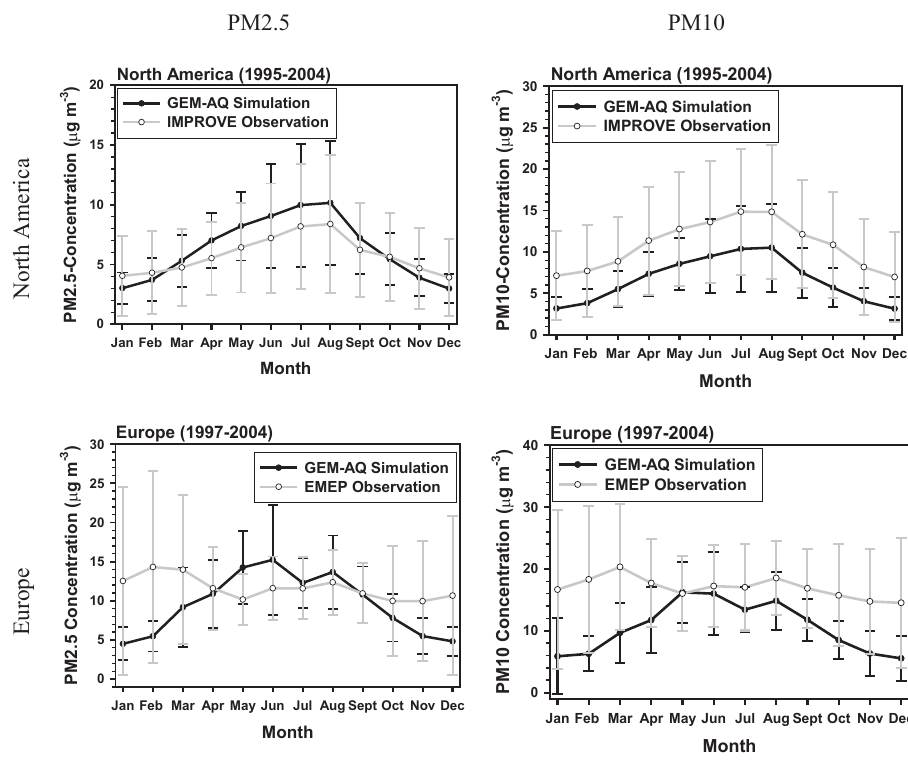
Fig. 12. Comparisons of simulated monthly PM 2 . 5 and PM 10 concentrations in North America and Europe with observations.